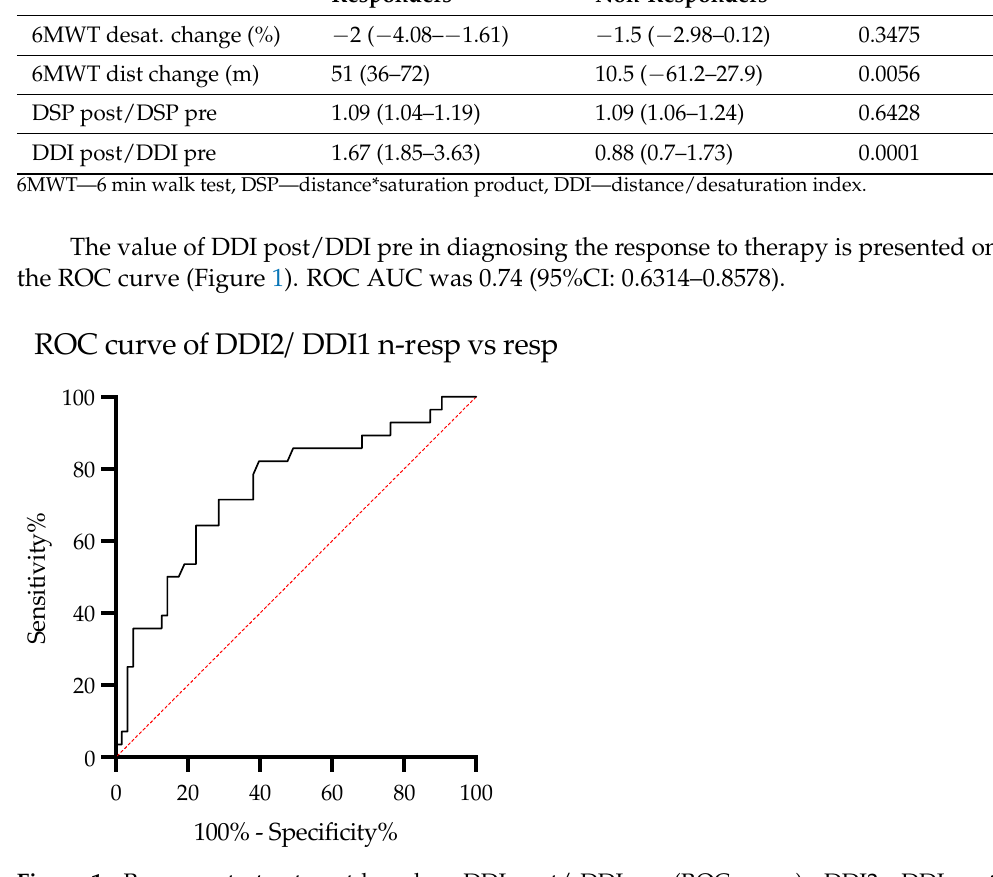
Table 6. Treatment-related change (medians with 95% CI) in 6MWT parameters according to the type of response to treatment (Mann-Whitney test).